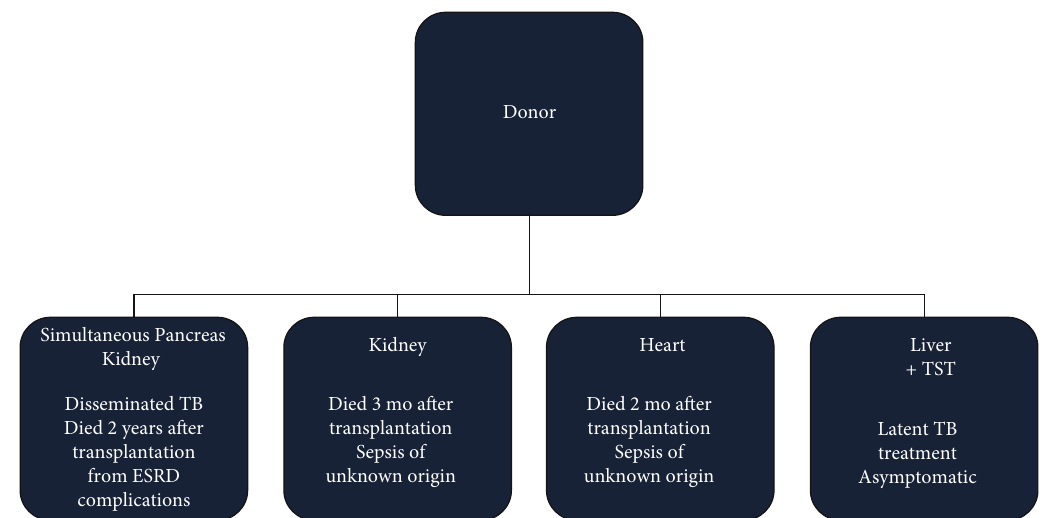
Figure 1: Diagram showing the evolution of patients who received organs from the donor with tuberculosis. ∗ SPK recipient. Outcome: cured from tuberculosis. Death related to end-stage renal disease (ESRD) 2 years after